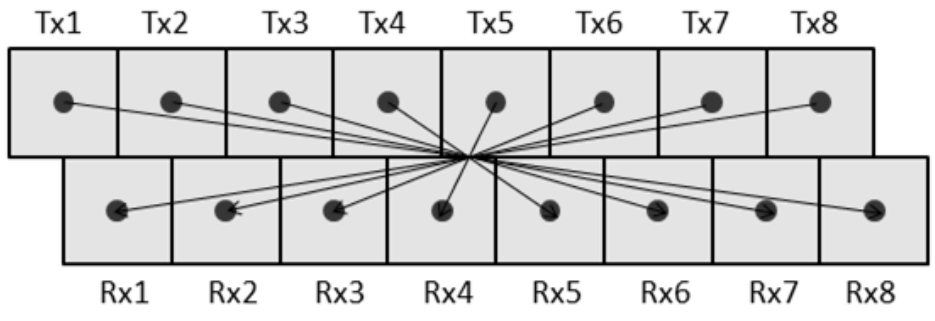
Figure 2. Antenna configuration of the Yakumo system.